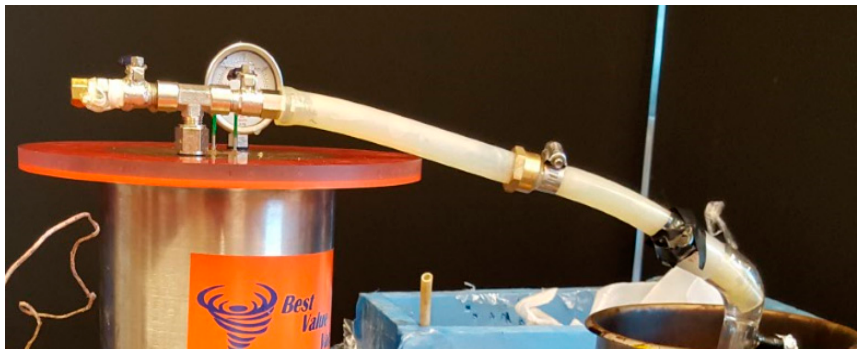
Figure 11. Releasing hydrocarbon gaseous products through the condensation system.